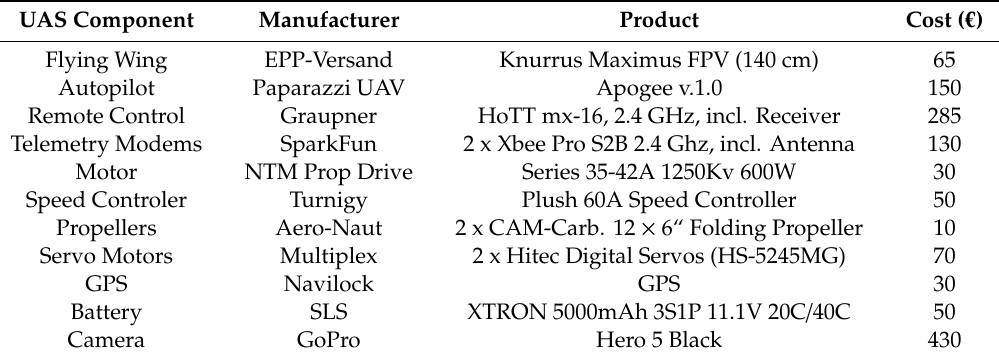
Table A1. Individual components of the UAS (the stated costs are only rough estimates).